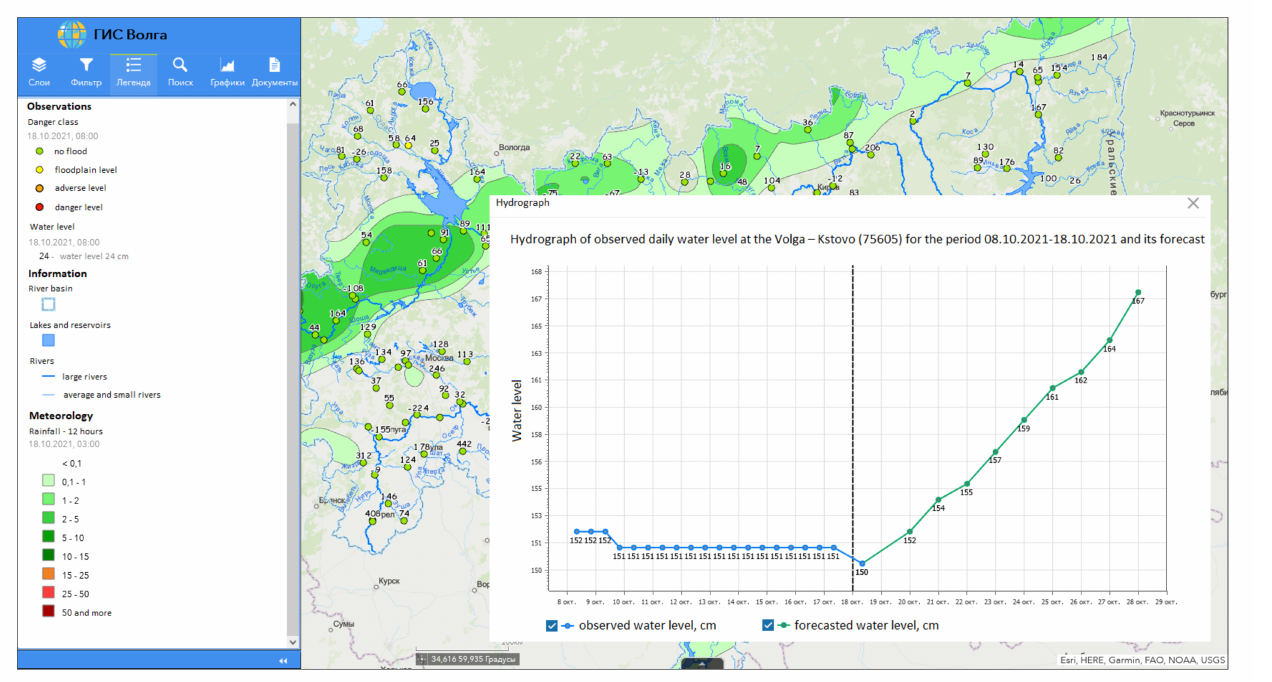
Figure 3. Hydrograph of observed daily water level at the Volga—Kstovo (75,605) for the period 8 October 2021–18 October 2021 and its